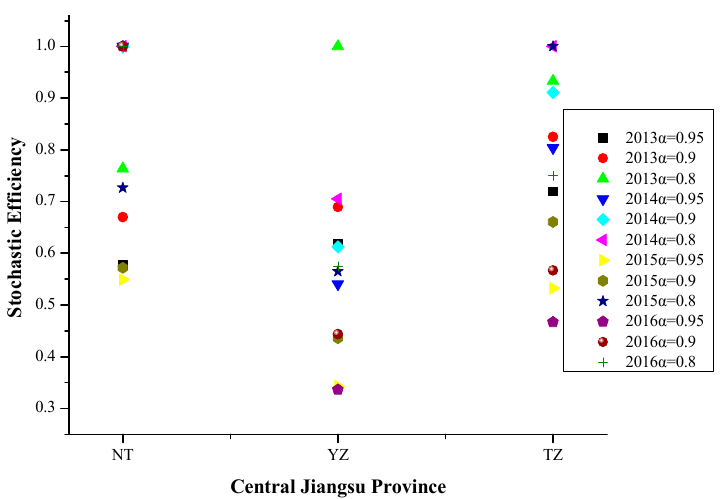
Figure 7. Stochastic efficiency values in central Jiangsu Province at different risk levels in 2013–2016.